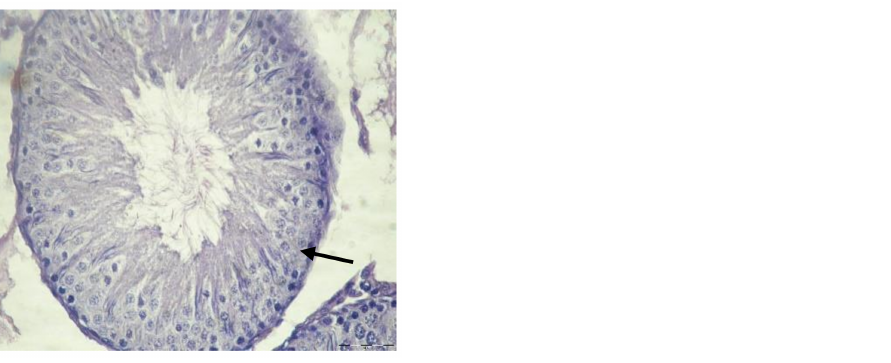
Figure 5. Section of testis of rats treated with EVOO and paracetamol for 15 days showing most seminiferous tubules with normal structure (arrow) ( × 400).